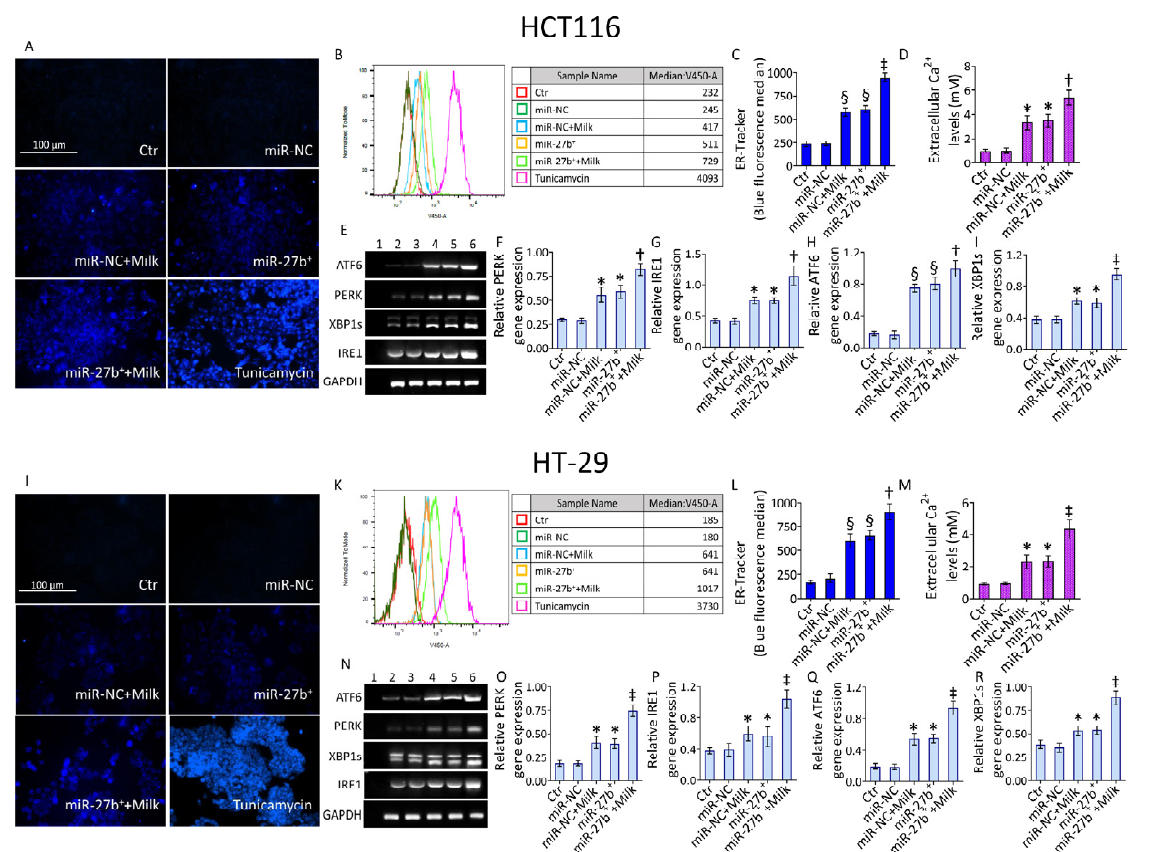
Figure 6. MiR-27b + +Milk triggered ER-stress. Representative images by fluorescence microscopy and FACS analysis of ER-tracker dye, expressed as blue fluorescence median, extracellular calcium content, and PERK, IRE1, ATF6, and XBP1s relative mRNA levels assessed in ( A – I ) HCT116 and ( J – R ) HT-29 cells transfected with 30 nM mimic Negative Control (miR-NC) and miR-27b mimic (miR-27b + ) or with miR-NC and miR-27b + before 72 h with 40% v / v milk treatment (miR-NC+Milk and miR-27b + +Milk). Control cells (Ctr) were treated with the highest volume of HBSS-10 mM Hepes. Positive control was performed by using the ER-stress inducer tunicamycin (5 µ g/mL) for 16 h. Scale bars = 100 µ m. Lane 1 = negative control lacking cDNA template; lane 2 = Ctr; lane 3 = miR-NC; lane 4 = miR-NC+Milk; lane 5 = miR-27b + ; lane 6 = miR-27b + +Milk. Levels of mRNA for PCR were adjusted to the GAPDH endogenous control and calculated using ImageJ software. The predicted sizes of the amplified transcripts are visualized on 2.0% agarose gels. * p < 0.05 vs. miR-NC; § p < 0.01 vs. miR-NC; † p < 0.05 vs. miR-27b + ; ‡ p < 0.01 vs. miR-27b + .